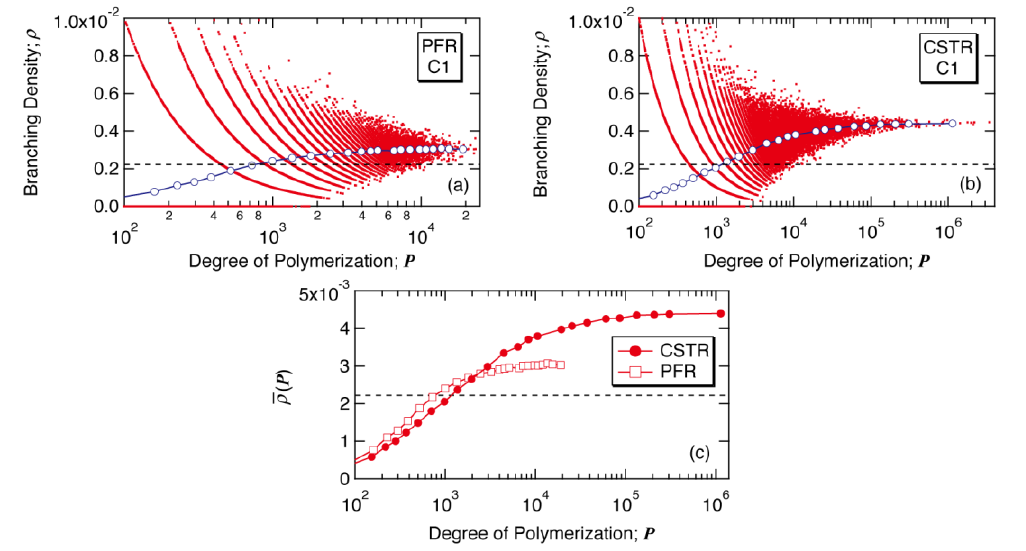
Figure 3. Relationship between branching density ρ and degree of polymerization P for the branched polymers formed in ( a ) a PFR and in ( b ) a CSTR, and ( c ) ( ) P  for both types of reactors. The calculation condition is the same as in Figure